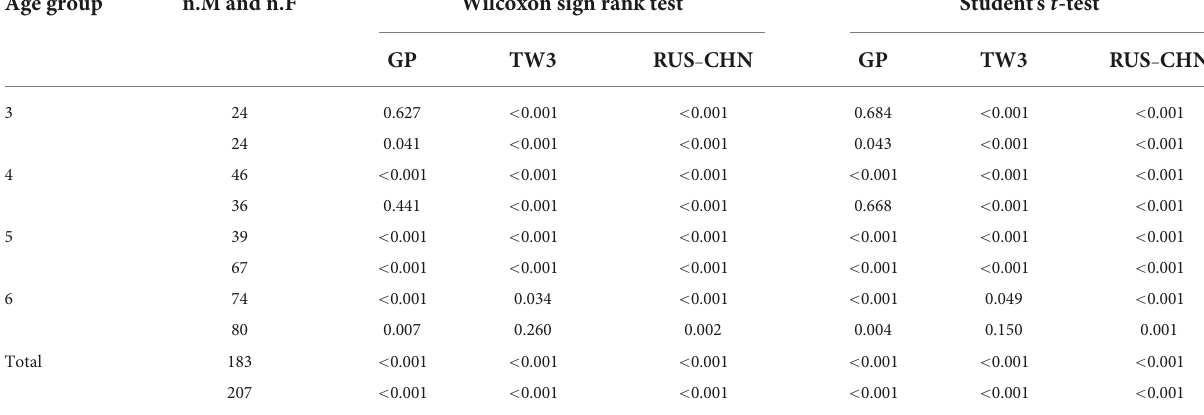
TABLE 2 P -values for the performed hypothesis tests by sex and age